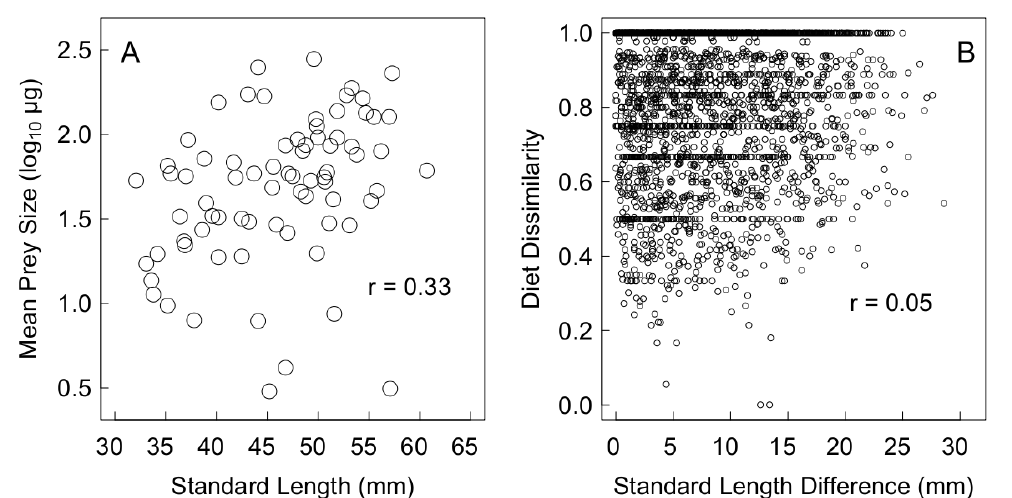
Figure 3. Relationships between size and diet in 75 wild-caught stickleback from Blackwater Lake. a) Mean prey size is positively correlated with standard length, while b) Pairwise diet dissimilarity between individual stickleback is positively but non-significantly correlated with difference in standard length.